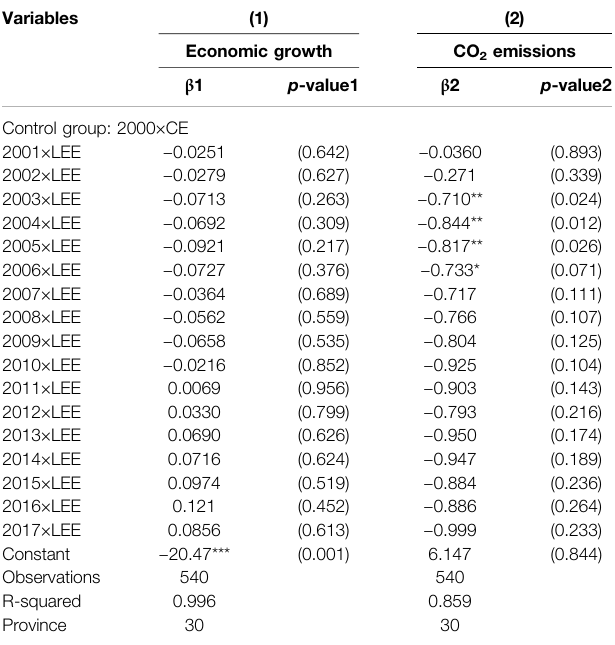
TABLE 11 | Annual effects of LEE on CO 2 emissions and economic growth.